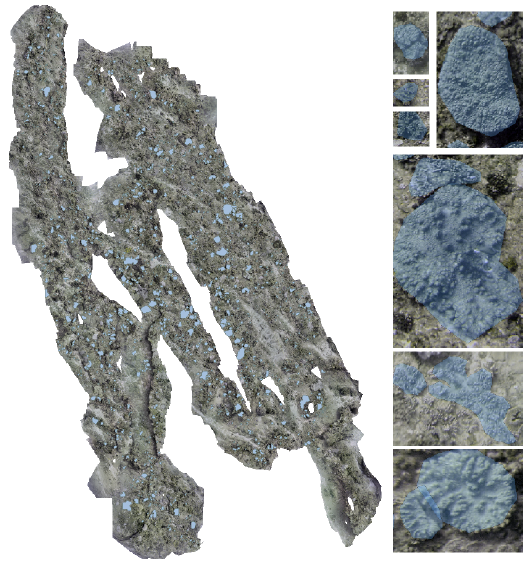
Figure 5. The Mozambique geo-referenced ortho-mosaic with the corresponding polygonal labels. On right, some examples of annotated